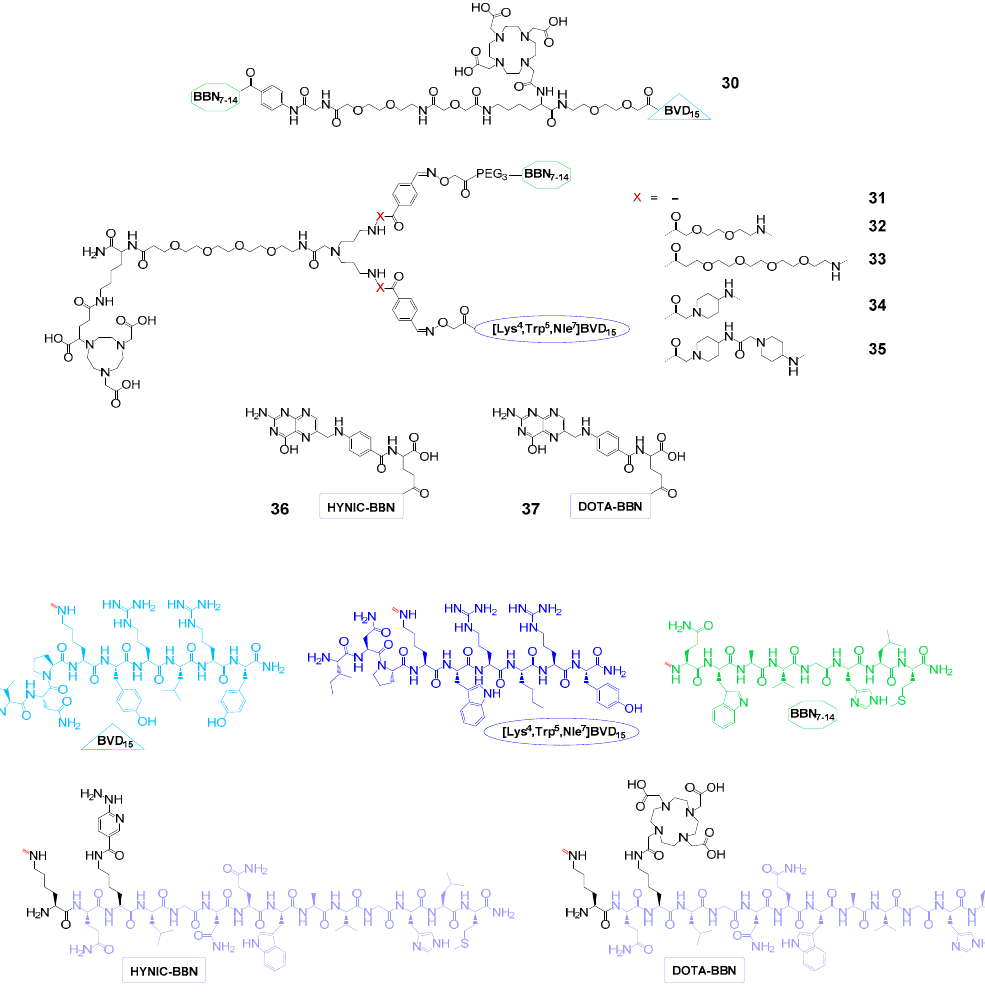
Figure 9. Structures of GRPR- and NPY(Y 1 )R-bispecific and GRPR- and folate receptor-bispecific agents developed for breast cancer imaging or therapy.